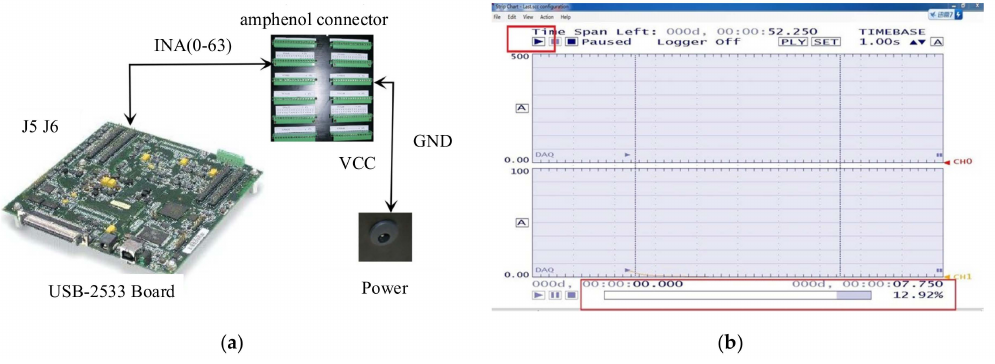
Figure 5. Data acquisition box for recording the data from laser sensors and dynamos ( a ) composition diagram, ( b ) operation